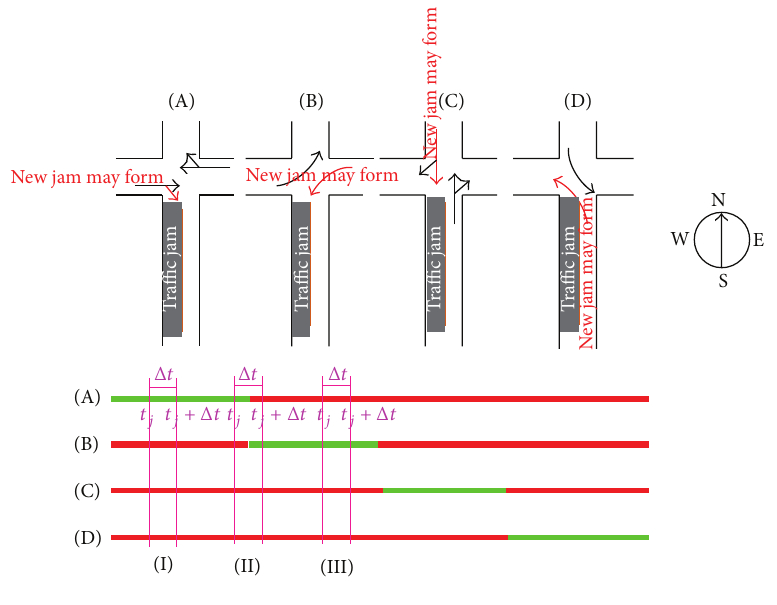
Figure 28: Block of upstream